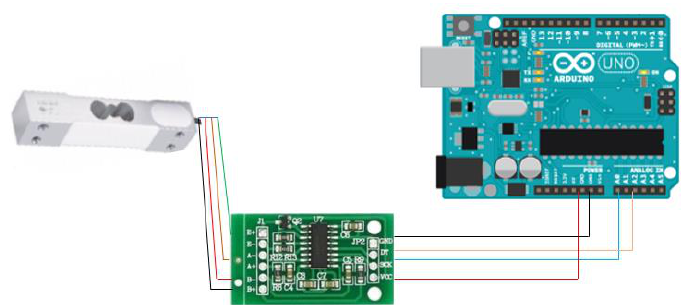
Figure 27. HX711 system: load cell (left); HX711 chip (middle); Arduino Nano (right).